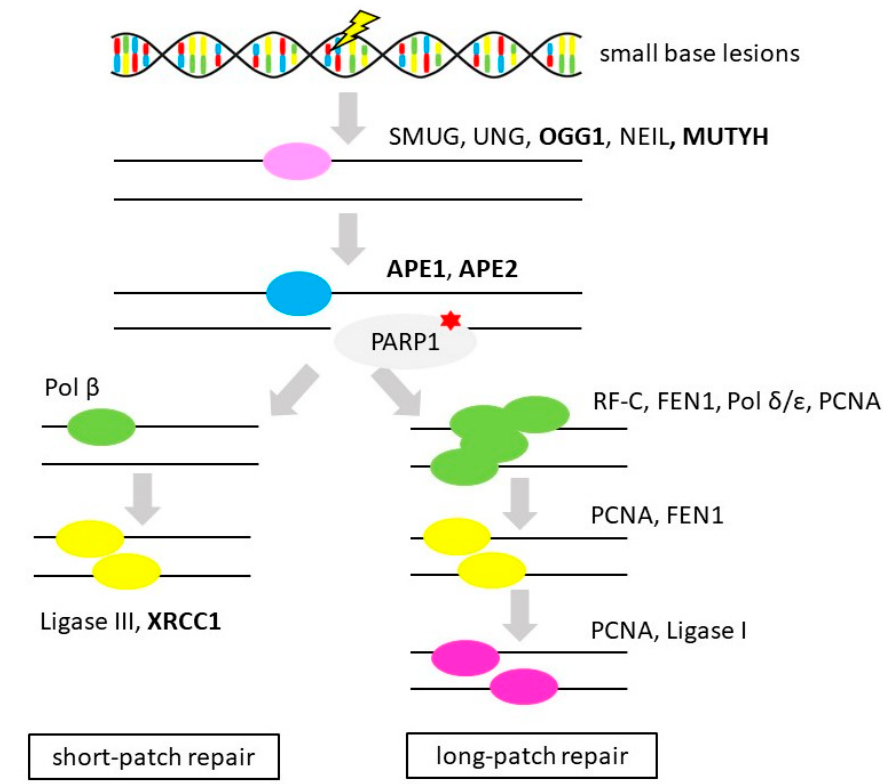
Figure 5. Base excision repair. Simplified scheme of base excision repair of small base lesions (gene alternations in OvC in bold, therapeutic interventions considered in OvC therapy marked by red star (PARP inhibitors)) [128]. Protein names: single-strand selective monofunctional uracil DNA glycosylase (SMUG), uracil DNA glycosylase (UNG), 8-oxoguanine DNA glycosylase 1 ( OGG1 ), endonuclease VIII-like (NEIL), MutY DNA glycosylase (MUTYH), apurinic / apyrimidinic endonuclease 1 and 2 (APE1 and 2), poly(ADP-ribose) polymerase 1 (PARP1), DNA polymerase beta, delta and epsilon (POLB, -D, -E), DNA ligase 1 and 3 (LIG1 and 3), X-ray repair cross-complementing 1 (XRCC1), replication factor C (RFC), Flap endonuclease 1 (FEN1), proliferating cell nuclear antigen (PCNA) [44]. DNA glycosylases (e.g., single-strand selective monofunctional uracil DNA glycosylase (SMUG),